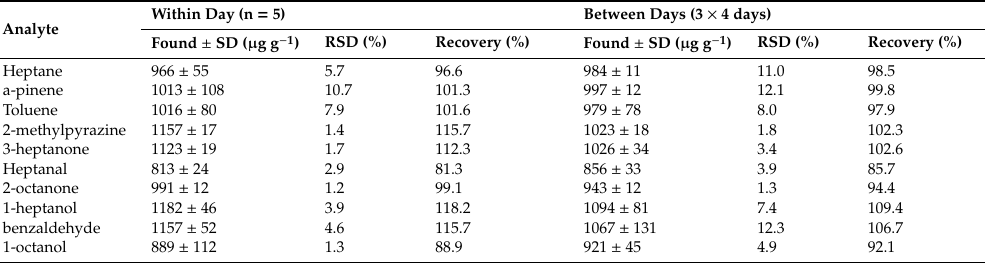
Table 2. Accuracy and precision results of method validation for the determination of volatile compounds in nut-based milk alternative